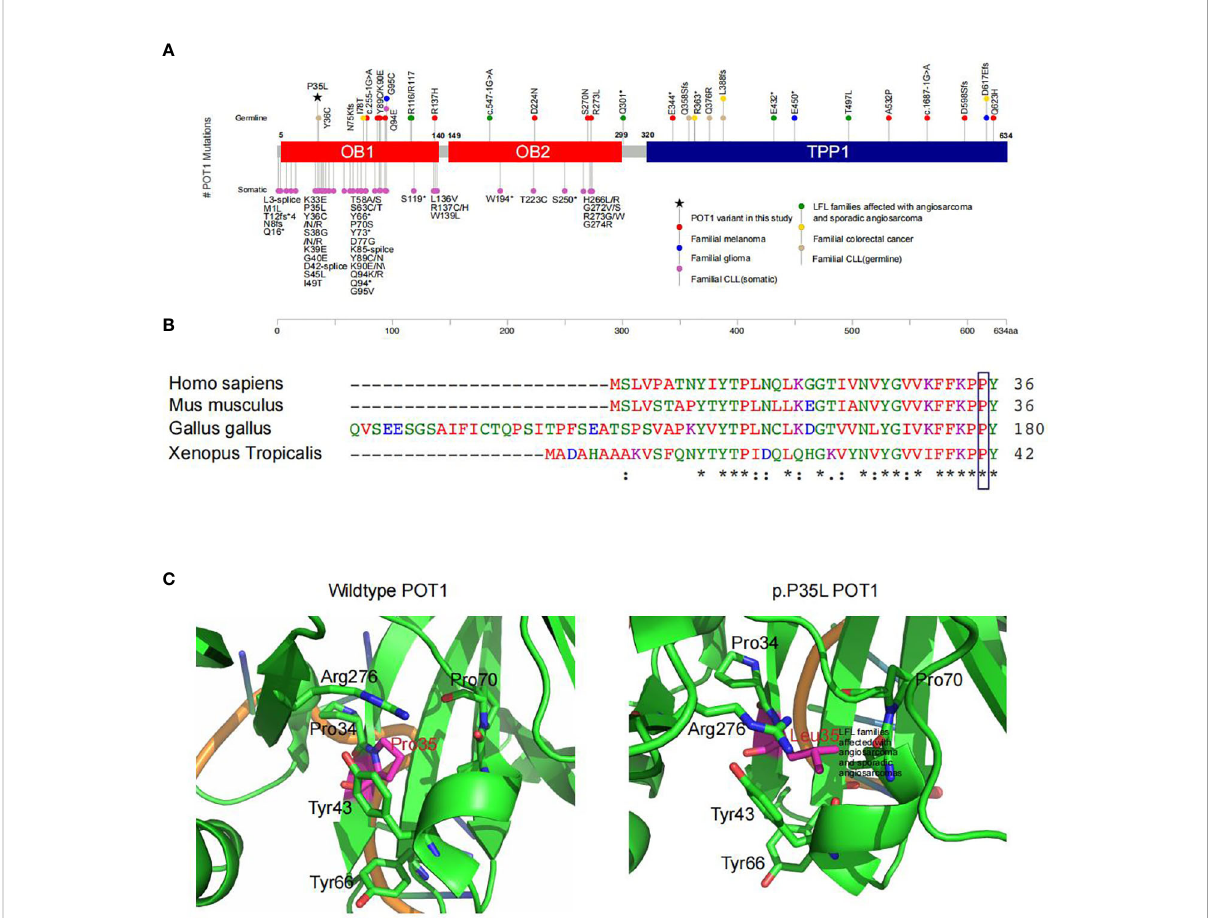
FIGURE 2 Functional prediction of the POT1 variant in association with LFL. (A) Summary of reported POT1 variants. Germline and somatic variants in POT1 underlie a series of familial cancers, including angiosarcoma (green), glioma (blue), melanoma (red), colorectal cancer (yellow) and chronic lymphocytic leukemia (pink and light brown) as indicated. The POT1 p.P35L variant detected in this pedigree is marked with a black asterisk, which is located in one of the OB fold domains. (B) Sequence alignment showing strong conservation of the POT1 p.P35 residue across different orthologues. An “ * ” (asterisk) indicates positions which have a single, fully conserved residue. A “ : ” (colon) indicates conservation between groups of strongly similar properties. A “ . ” (period) indicates conservation between groups of weakly similar properties. (C) In silico structural modeling of the POT1 protein indicated change of the proline residue at position 35 to leucine led to signi fi cant conformational change of the protein, which would affect binding of the